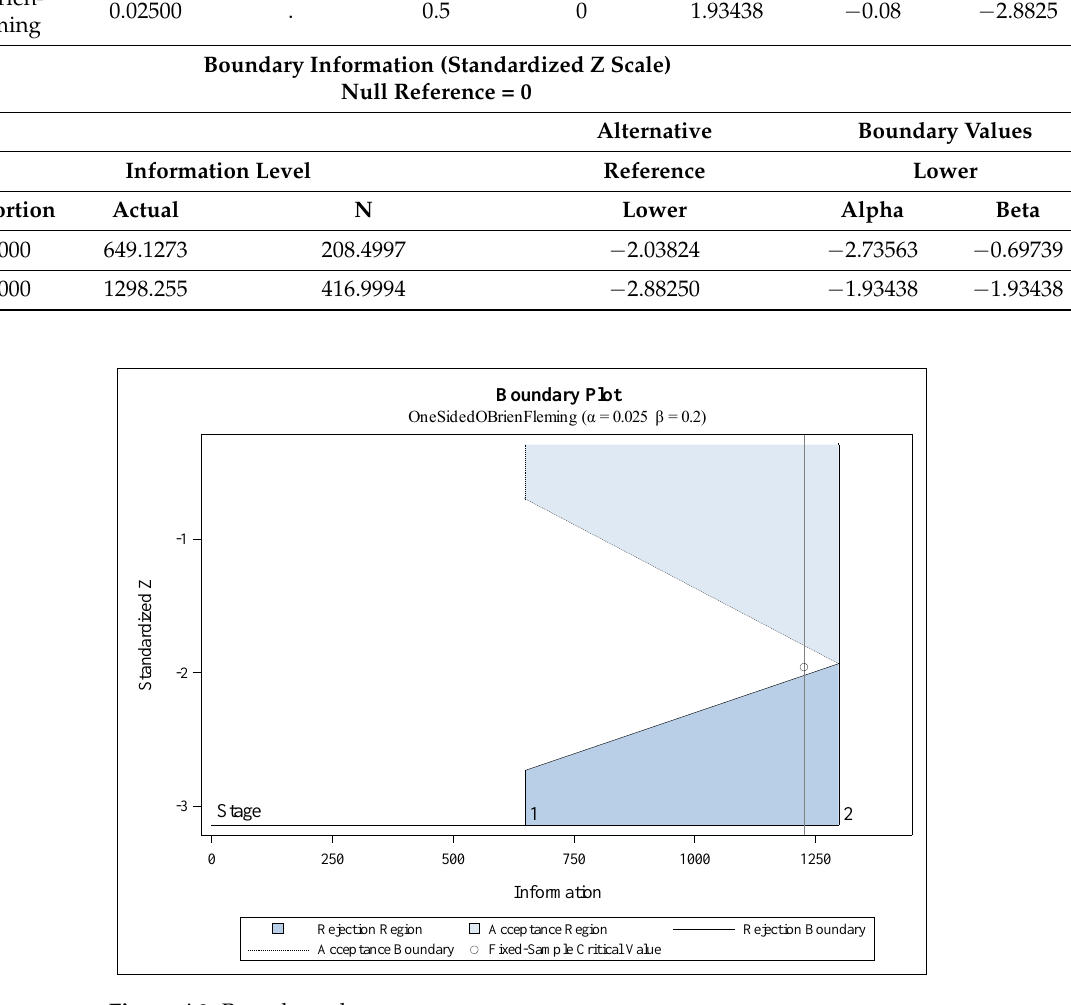
Figure A2. Boundary plot. Table A4. Ceiling-Adjusted Design Boundary Information.